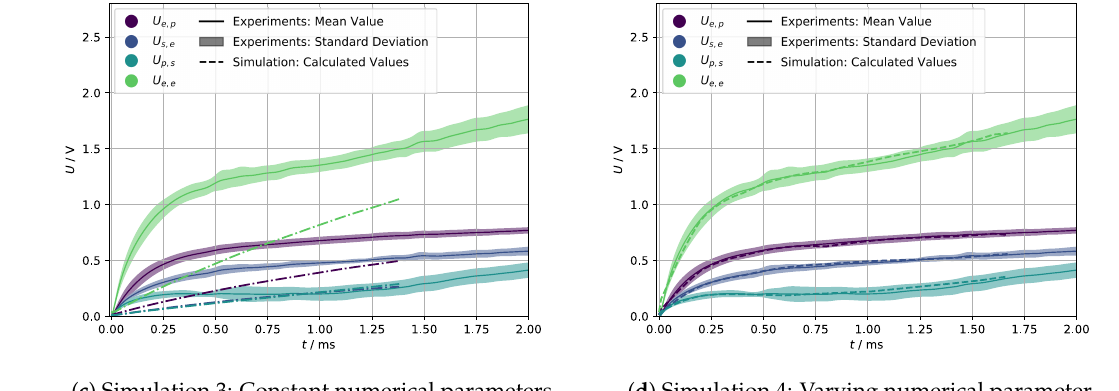
Figure 6. Effect of the numerical parameters ξ and κ (Tables A6 and A7) on the simulated electric voltage curve and comparison with the experimental